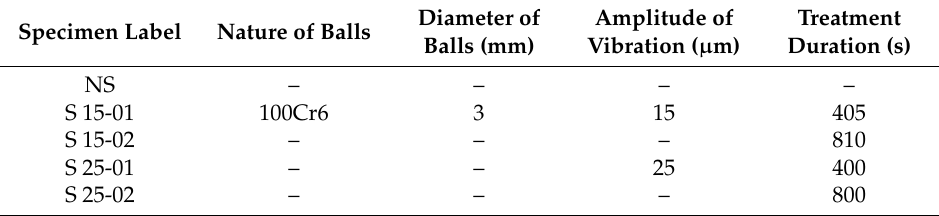
Table 2. Surface Mechanical Attrition Treatment (SMAT)